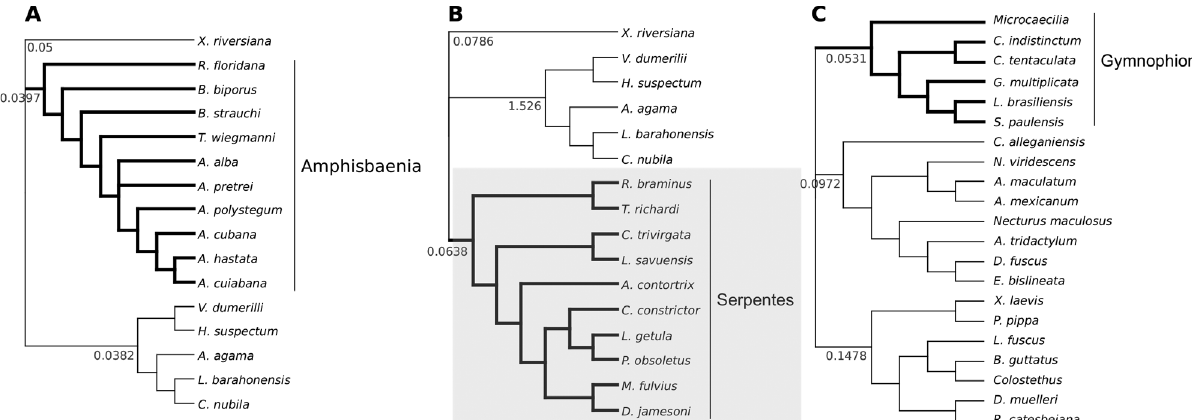
Figure 1 - Topology used for test models of molecular signatures of HoxA13 in limbless lineages. The models of molecular signatures of HoxA13 were tested in the three main comparisons. A) limbed lizards versus Amphisbaenia; B) limbed lizards versus Serpentes; C) limbed amphibians (anurans and salamanders) versus Gymnophiona. The tree to conduct the analyses of variable (cid:2) among lineages and sites is based on published literature (Pyron et al. , 2013 for Squamata and Pyron and Wiens. 2011 for Lissamphibia). The bold branches correspond to the groups labeled as ‘foreground branches’. The shaded tree represents the one where the branch-site model identified signatures of positive selection. The values represented in each branch correspond an independent (cid:2) ratio that corresponds to ratio of the rate of non-synonymous substitutions (dN) to the rate of synonymous substitutions (dS) in a maxi- mum likelihood